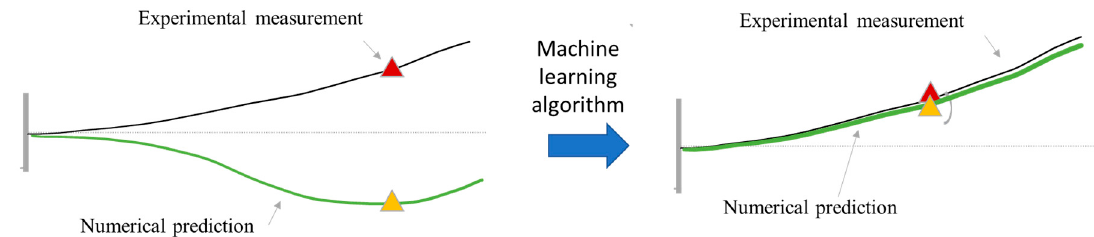
Figure 1. Concept of the approach. On the left, the numerical predictions before the application of the machine learning (ML) approach are not representative of the behavior of the system. After the ML algorithm is applied, the numerical prediction is a good representation of the actual system.